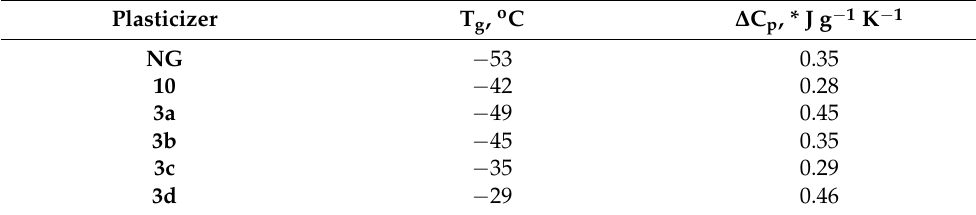
Table 7. Glass transition temperature (Tg) of NC /plasticizer mixtures (50/50).